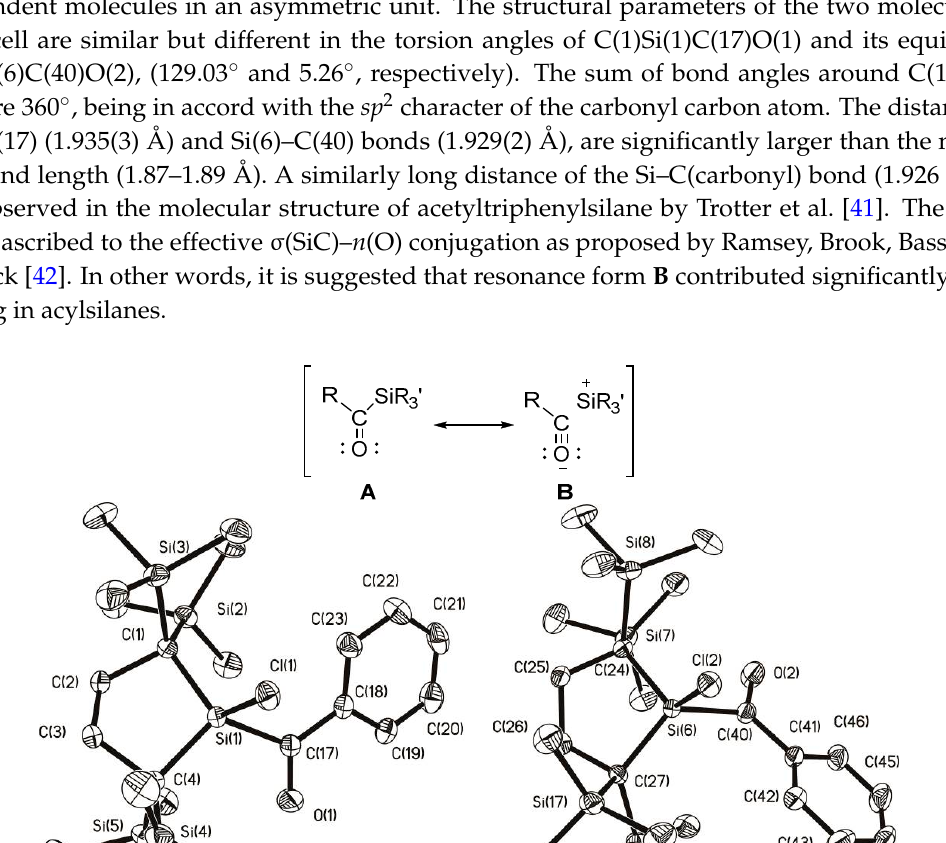
Figure 2. ORTEP drawing of the independent molecules in 3b . (Hydrogen atoms are omitted for clarity. Thermal ellipsoids are shown at the 30% probability level.) Selected bond lengths (Å) and angles (°): Si(1)–C(1) 1.883(4), Si(1)–C(4) 1.898(4), Si(1)–C(17) 1.940(4), Si(1)–Cl(1) 2.1003(14), C(17)– O(1) 1.223(5), Si(6)–C(28) 1.888(4), Si(6)–C(25) 1.887(4), Si(6)–C(41) 1.927(4), Si(6)–Cl(2) 2.0967(15), C(41)–O(2) 1.216(5); C(1)–Si(1)–C(4) 102.26(17), C(17)–Si(1)–Cl(1) 97.97(13), O(1)–C(17)–C(18) 119.7(4), O(1)–C(17)–Si(1) 113.2(3), C(18)–C(17)–Si(1) 126.9(3), C(28)–Si(6)–C(25) 102.12(16), C(41)–Si(6)–Cl(2) 98.33(14), O(2)–C(41)–C(42) 119.1(4), O(2)–C(41)–Si(6) 114.4(3), C(42)–C(41)–Si(6) 126.3(3).